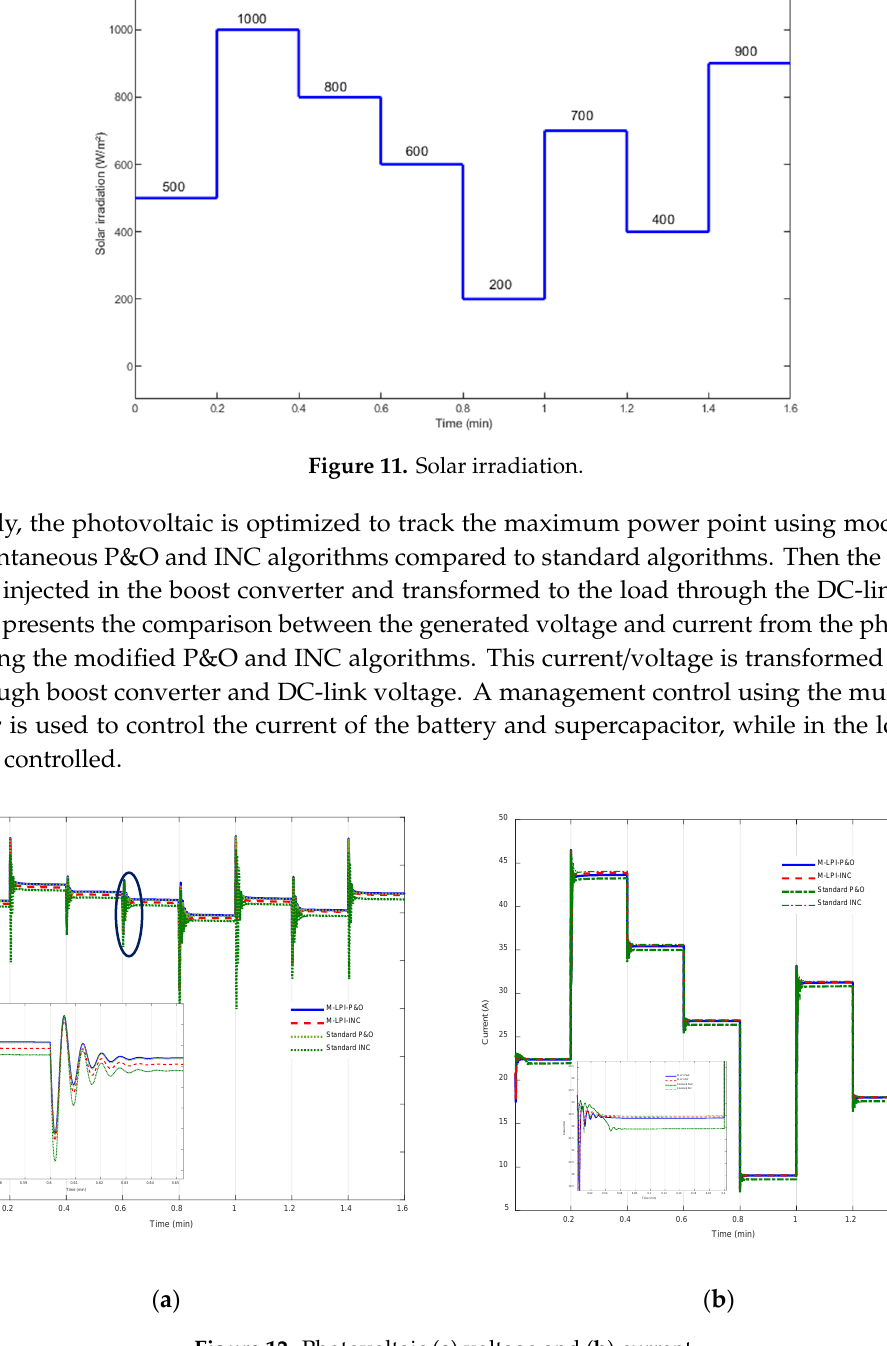
( b ) Figure 13. ( a ) Voltage and ( b ) Current the supercapacitor and battery. The generated energy from the renewable energy source is stable and shows a small fluctuation when the solar irradiation changes from one value to another only at the beginning. This fluctuation is eliminated by the supercapacitor discharge.